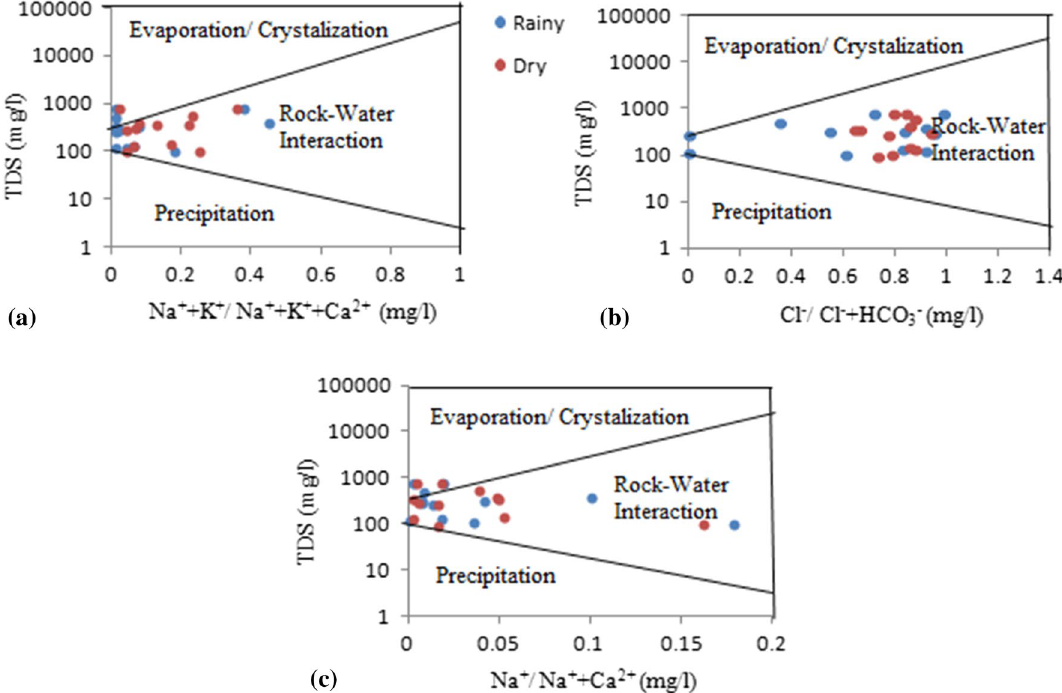
Fig. 15 Modified versions of Gibbs